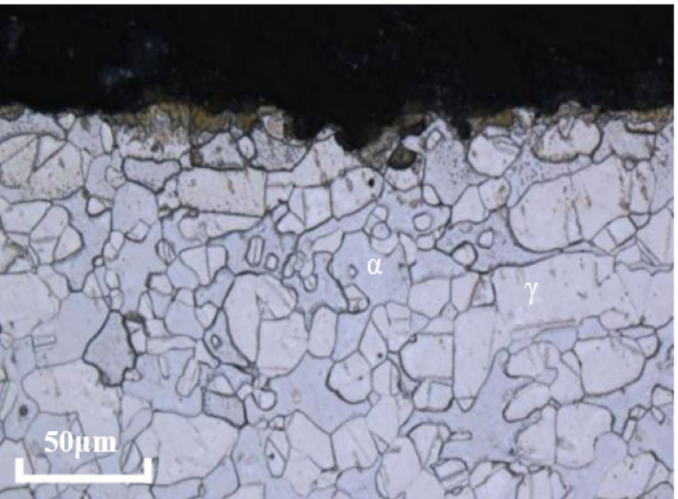
Figure 16. Cross-sectional morphology of 2205 duplex stainless steel sample without corrosion product film after testing in 180 ◦ C acid solution with corrosion inhibitor.